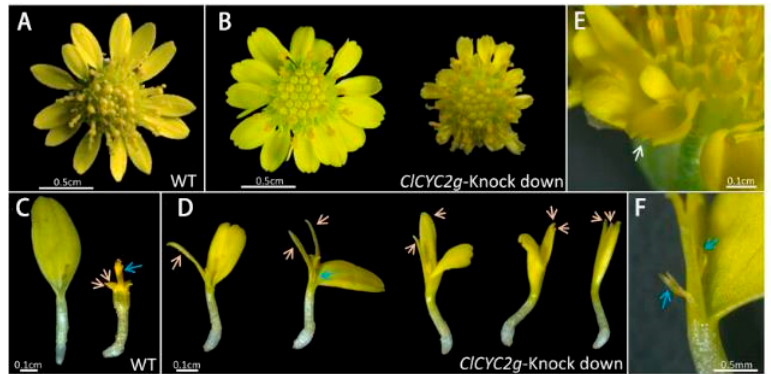
Figure 5. Knockdown of ClCYC2g expression adversely affects the formation of symmetrical marginal florets in the radiate capitulum in chrysanthemum [97] . ( A , B ) Morphology of the capitulum of wild-type (WT) and transgenic C. lavandulifolium . ( C ) Ray and disc florets of wild-type C. lavandulifolium . ( D ) Ray-shaped florets with gradually increasing mutations. Orange and blue arrows indicate abnormal petals and stamens, respectively. ( E , F ) Expanded marginal florets of the transgenic lines. White and blue arrows indicate the bilabiate corolla with a deeply dentate limb apex and stamens, respectively. Reprinted with permission from Ref. [97]. Copyright © 2023 Society for Experimental Biology and John Wiley & Sons Ltd. (Hoboken, American).